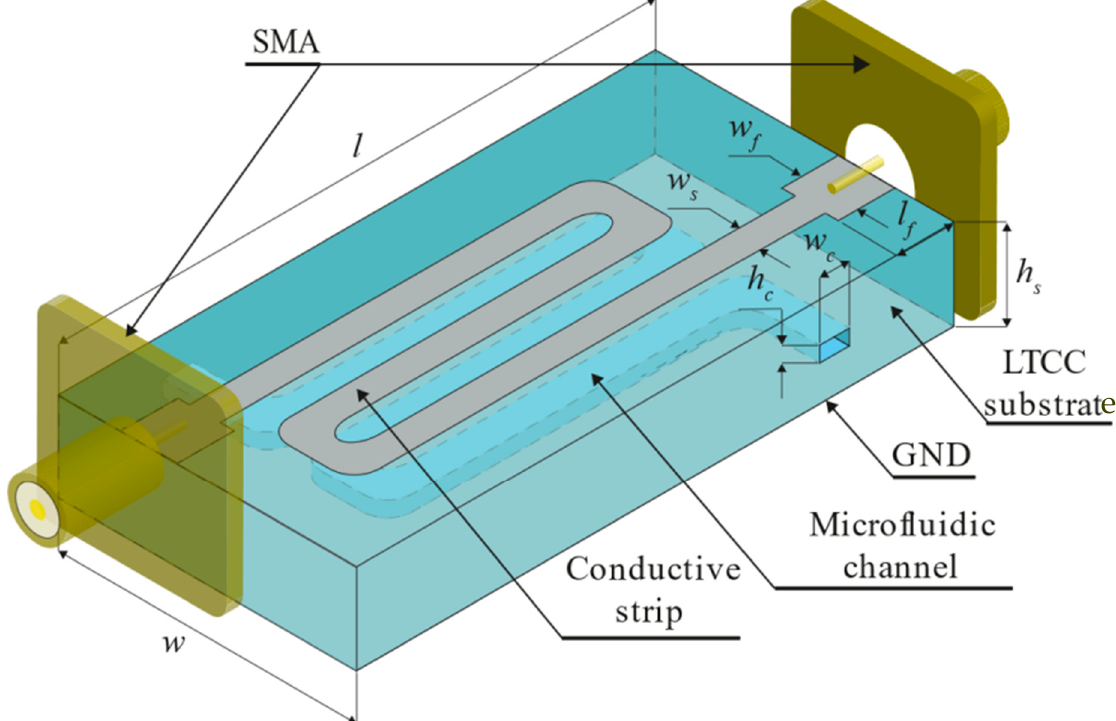
Figure 2. Illustrative visualization of the LTCC microwave microfluidic module with a long (meandered) microfluidic channel.